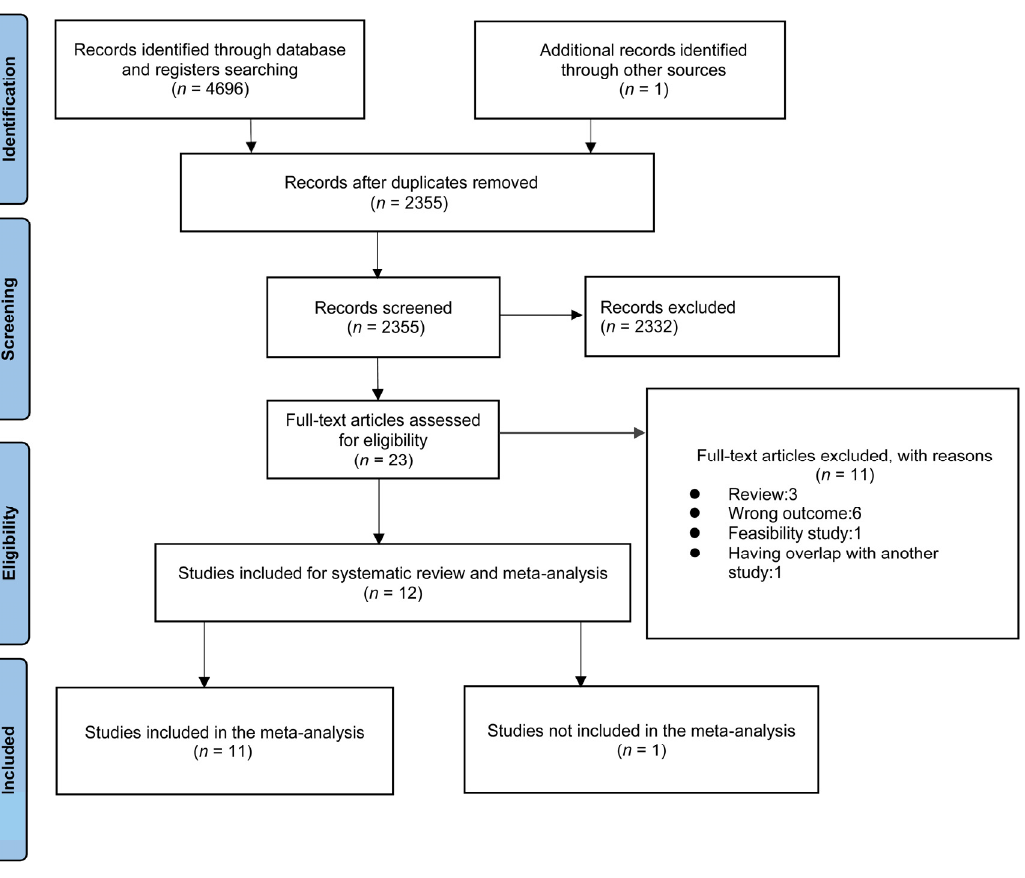
Figure 1. Preferred reporting items for systematic reviews and meta-analyses (PRISMA) flow dia-